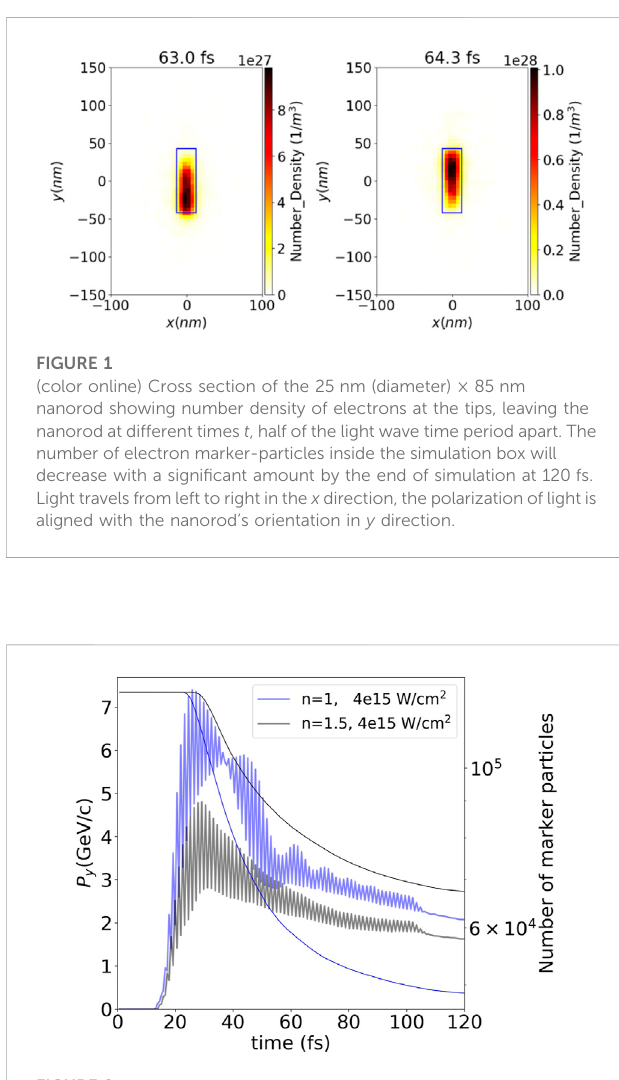
FIGURE 2 (coloronline)Weconsideralaserpulseofintensity I =4 · 10 15 W/cm 2 and duration of 106 fs. Here we show the time dependence of the total polarity directed momentum of the conducting electrons in the nanorod. The nanorod isinsurrounding UDMA-TEGDMA copolymer (black line)and in vacuum (blue line). The UDMA-TEGDMA copolymer decreases the momentum of the emitted (as well as the number of electrons “ spilled ” out during the process shown by the right axes of the fi gure) considerably compared to the emission to vacuum. Right axis on the fi gure shows the number of marker particles still present in the simulation